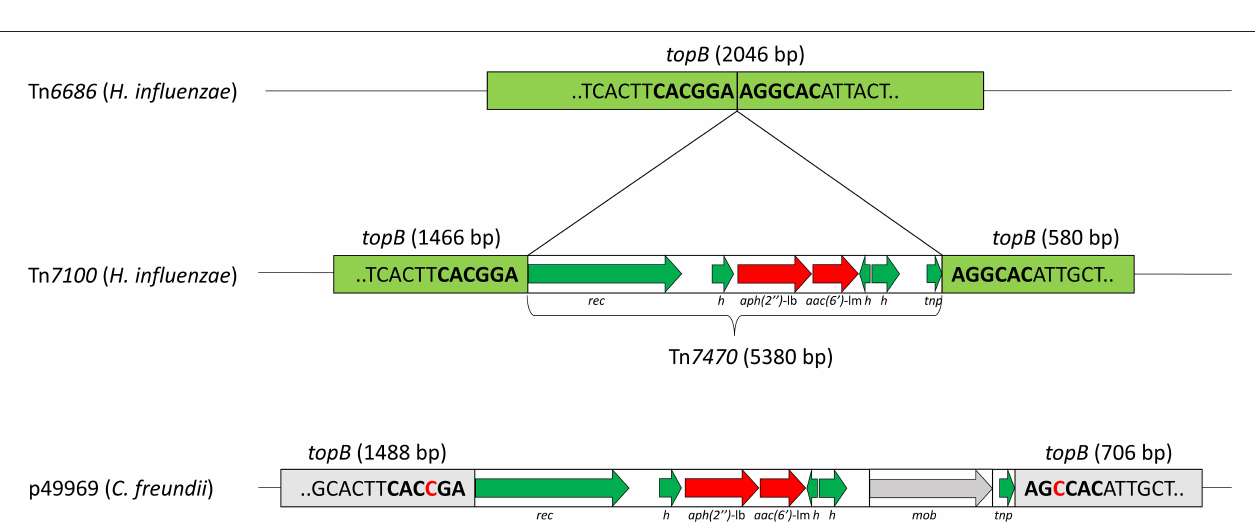
FIGURE 2 | Schematic presentation of the transposable element Tn 7470 , representing 7.3% of Tn 7100 . Refer to Figure 1 for location on Tn 7100 . Tn 7470 consists of a 5,380-bp insertion in the topB gene encoding DNA topoisomerase III (light green) (QEA08733), with the insertion site consisting of 6-bp inverted repeats (bold). Tn 7470 carries the aminoglycoside resistance genes aph(2 ′′ )- Ib and aac(6 ′ ) -Im (red arrows) and encodes a recombinase ( rec ) and a TnpW family transposase ( tnp ) and three hypothetical proteins ( h ) (green arrows). Tn 7470 shares 99.96% identity with an insertion in topB in plasmid p49969 (CP070545) from Citrobacter freundii strain CF49969 but differs from p49969 by lacking a 1,319-bp fragment encoding a MobA/MobL family protein ( mob ). The location of Tn 7470 in topB is similar to p49969 but the target sequences differ by one nucleotide (red text).